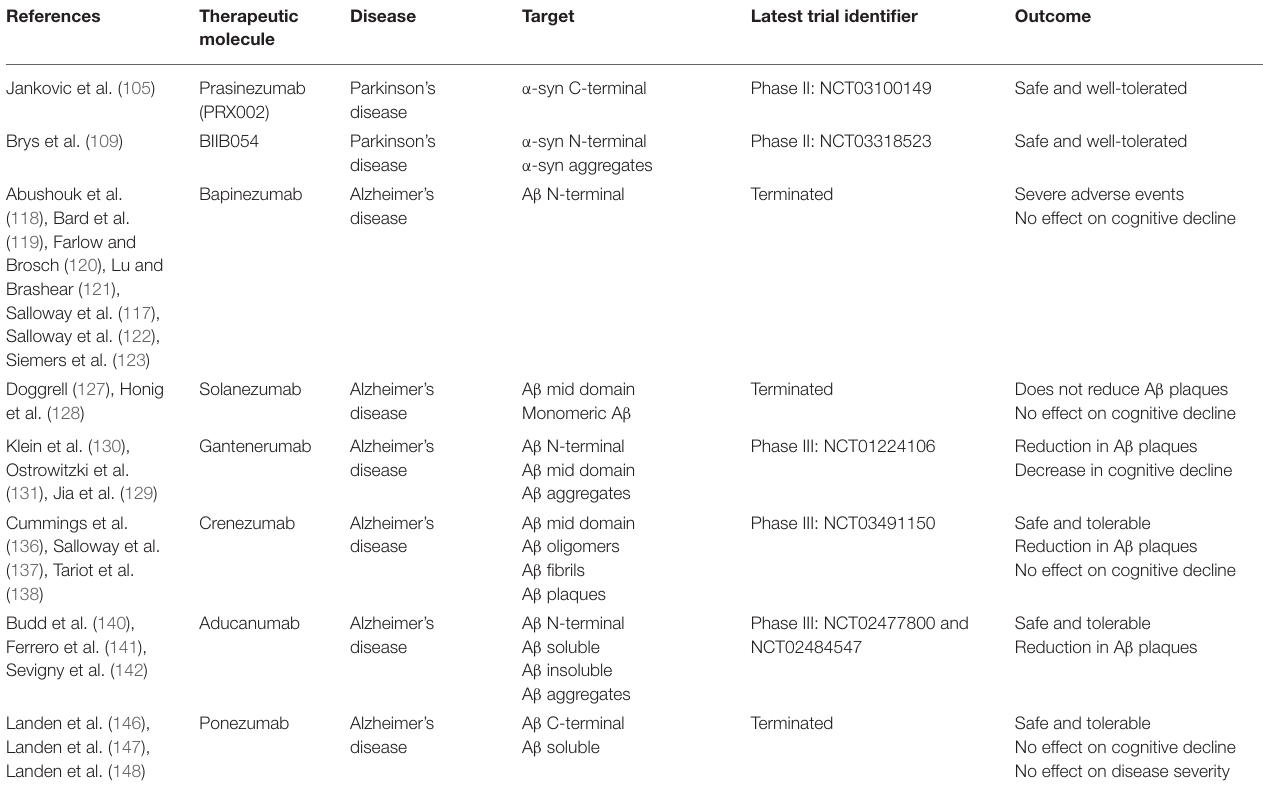
TABLE 2 | Study characteristics of passive immunotherapy clinical